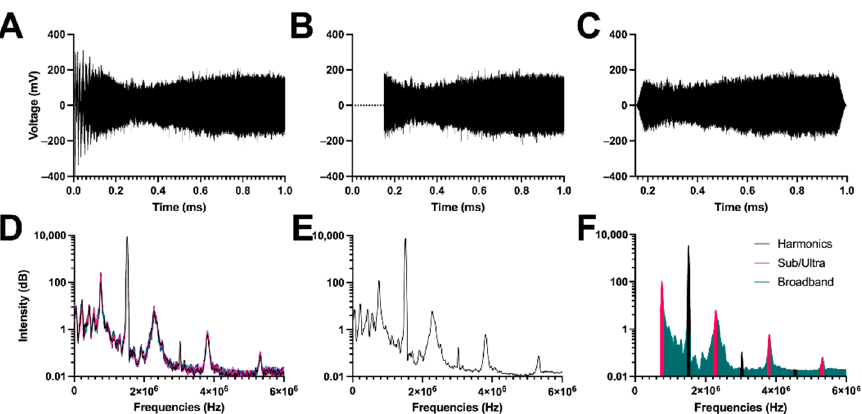
Figure 4. Signal processing of voltage versus time data obtained from the passive cavitation detector for 1.5 × 10 6 MBs/mL of 5 µm of MBs sonicated at 1.0 mechanical index. ( A – F ) Similar signal processing as Figure 3.